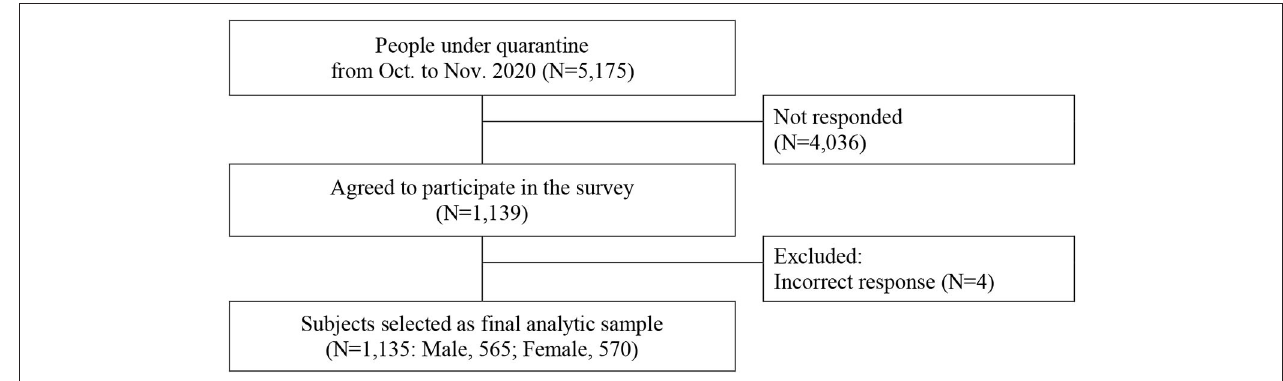
FIGURE 1 | Selection process of the study